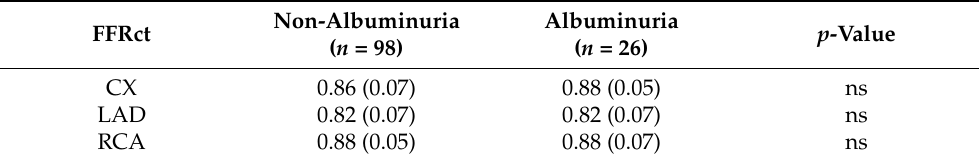
Right coronary artery.